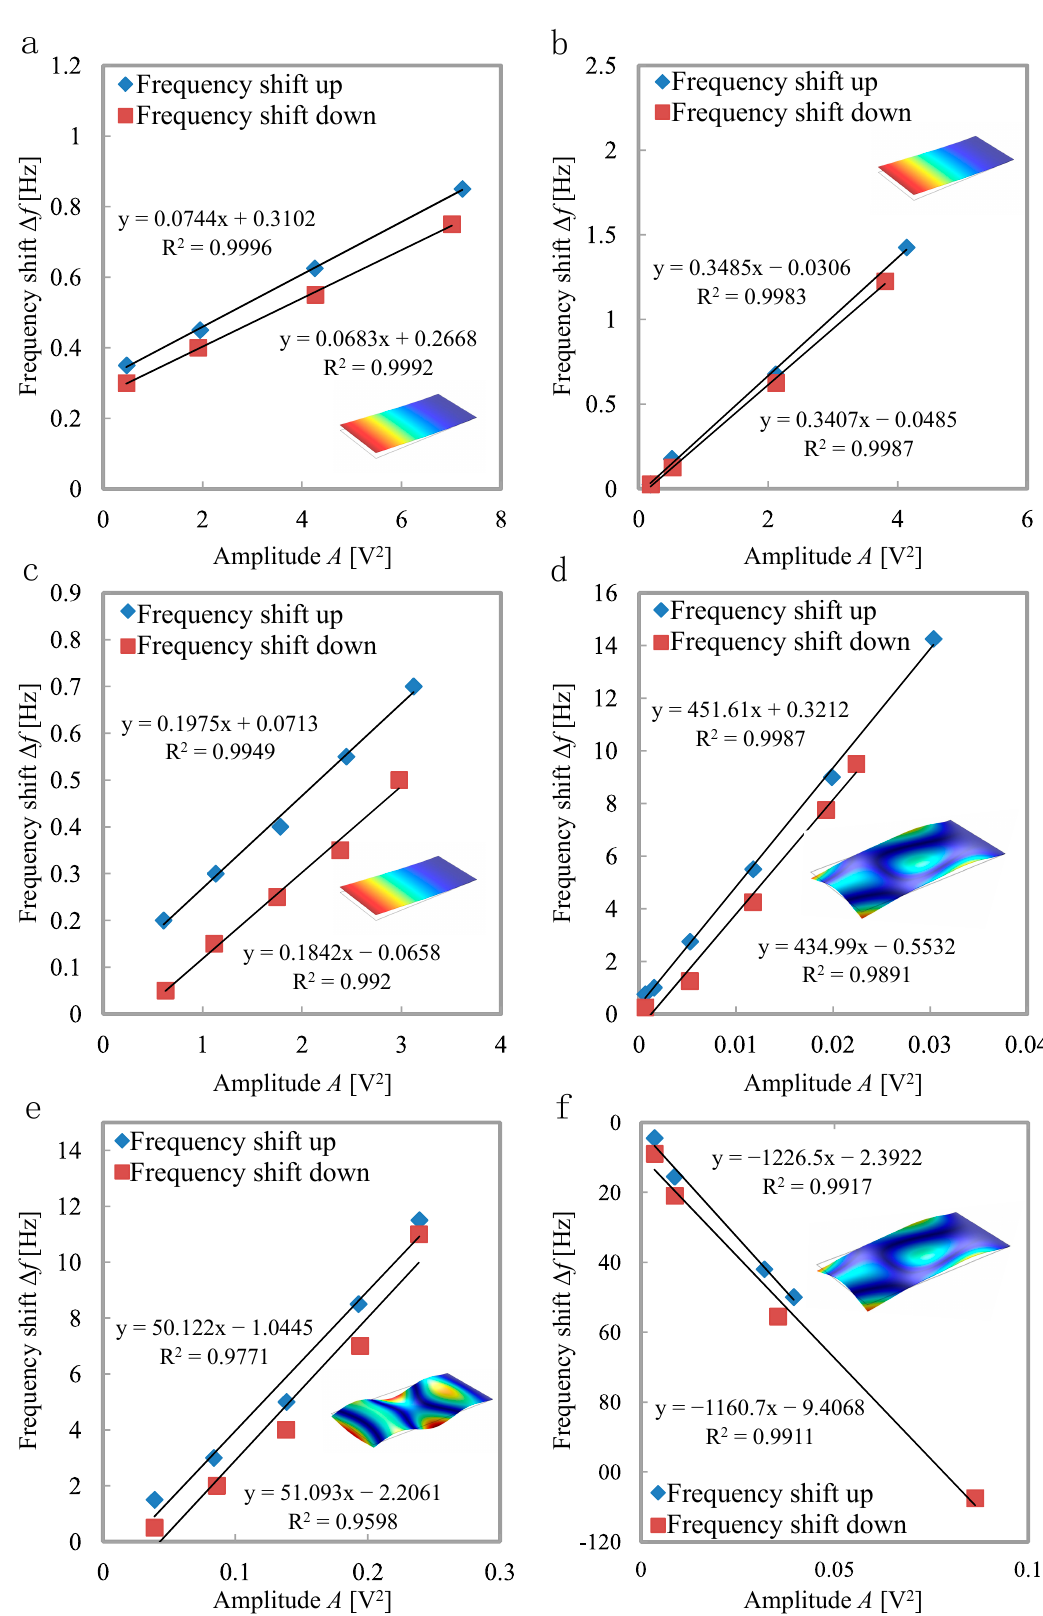
Figure 7. Frequency shift vs. squared measured amplitude for C_33 ( a ), C_50 ( b ), and C_100 ( c ) in the first bending mode, C_33 in the second roof-tile-shaped mode ( d ), C_100 in the fourth bending mode ( e ) and in the second roof-tile-shaped mode ( f ) at 0.001 mbar. The shape of the respective eigenmodes is shown in the inserts.